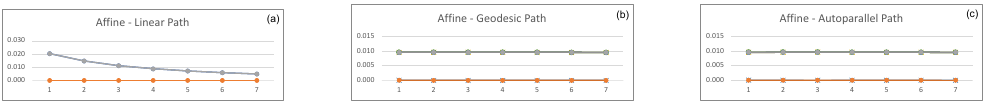
Figure 4. Affine general case results. ( a ) Left panel: geodesic trajectory shapes (black) plotted against the original parametric shapes (red). ( b ) Center panel: geodesic trajectory shapes (black) plotted against the shapes found via linear interpolation between the first and last shapes of the parametric dataset (red). ( c ) Right panel: geodesic trajectory shapes (black) plotted against autoparallel trajectory (red) built via shooting of the first two configurations of the geodesic.